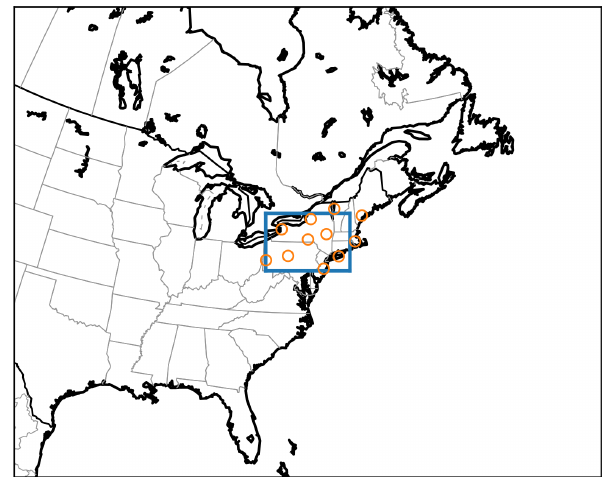
Figure 1. The study area in eastern North America. The blue rectan- gle indicates the area (720km × 490km), while the orange circles mark the locations of the NEXRAD